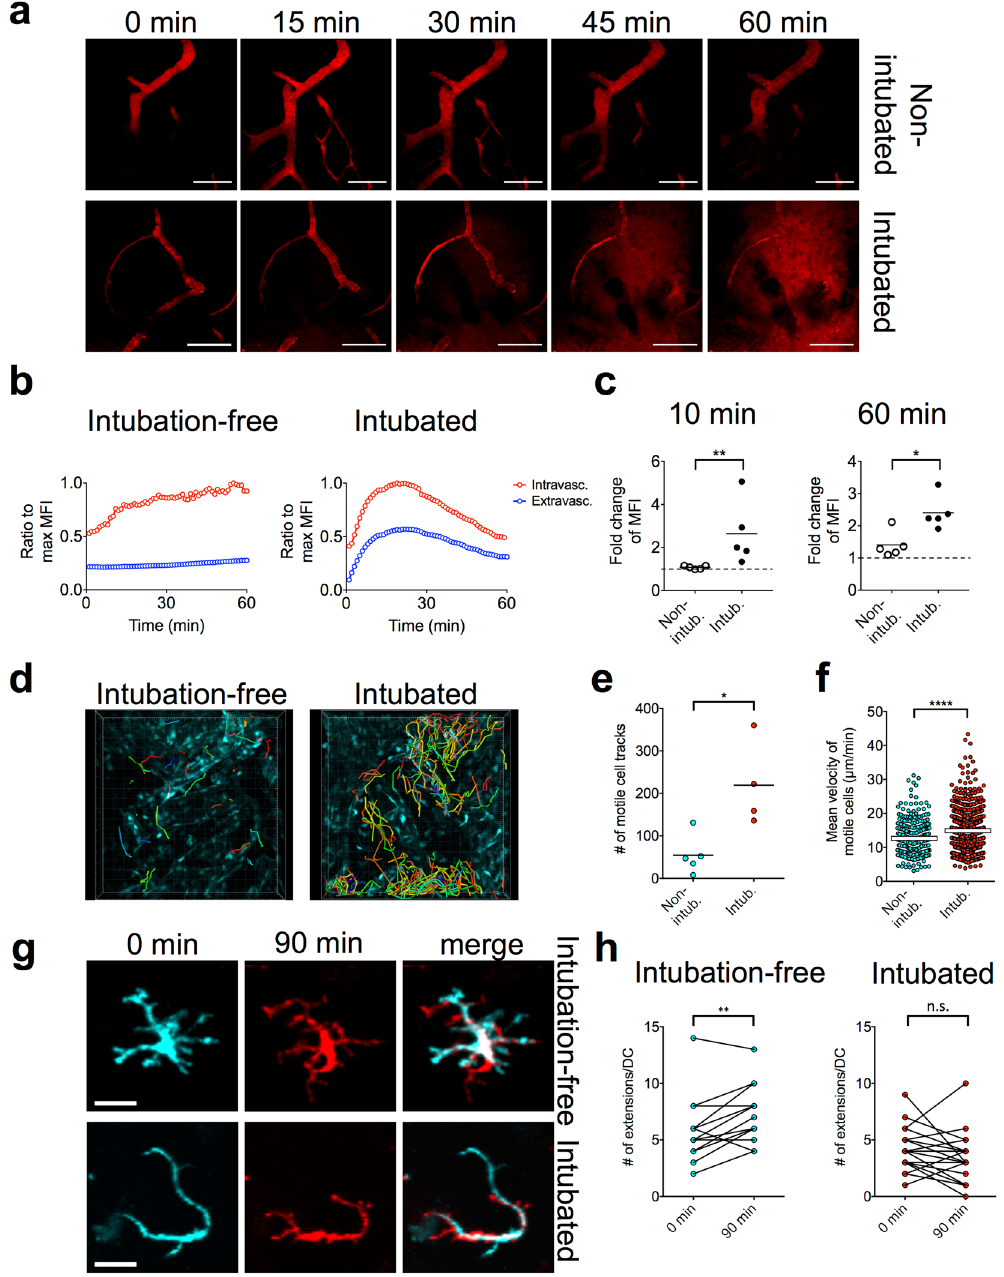
Figure 2. Comparison between the intubated and intubation-free setup. ( a – c ) Analysis of vascular leakage by i.v. injected fluorescent dextran, 155 kDa for ( a) ; 2,000 kDa for ( b and c ). ( a ) Snapshots from Supplementary Videos 1 and 3 are shown, bar = 100 µ m. ( b ) Changes of MFI in the intravascular vs. extravascular compartment during a 60 min imaging period. Curves are representative of 5 measurements performed with each setup. ( c ) Analysis of changes in MFI in the extravascular compartment at 10 min or 60 min after dextran injection. MFI of the extravascular space at 1 min was used as a reference (dashed line represents value of 1 = no change; * p < 0.05; ** p < 0.01 as determined using Mann-Whitney test, n = 5 mice). ( d – f ) Analysis of inflammatory cell recruitment to the interstitial space using ubiquitously fluorescent CAG-ECFP mice. ( d ) Snapshots from Supplementary Videos 1 and 3, colored lines indicate tracks of motile cells, grid spacing = 20 µ m. ( e ) Number of motile cell tracks within a defined volume of tissue (346 µ m × 346 µ m × 33 µ m), detected during a period of 60 min. Cells with a minimum speed of > 2 µ m/min were considered as motile ( * p < 0.05; as determined using Mann-Whitney test, n = 4–5 mice). ( f ) Analysis of mean velocities; each dot represents one cell. Data were pooled from the analysis of n = 4–5 mice ( **** p < 0.0001 as determined using Mann-Whitney test). ( g , h ) Analysis of IE-DC dynamic probing behavior. ( g ) Snapshots of individual IE-DCs at the beginning and at the end of a 90 min imaging period (with overlay, see also the corresponding Supplementary Videos 6 and 7), bar = 20 µ m. ( h ) Number of dendritic extensions/IE-DC; each dot represents an IE-DC. The same cell was analyzed at the beginning and at the end of a 90 min imaging period ( ** p < 0.01 and n.s.: non-significant, as determined using paired